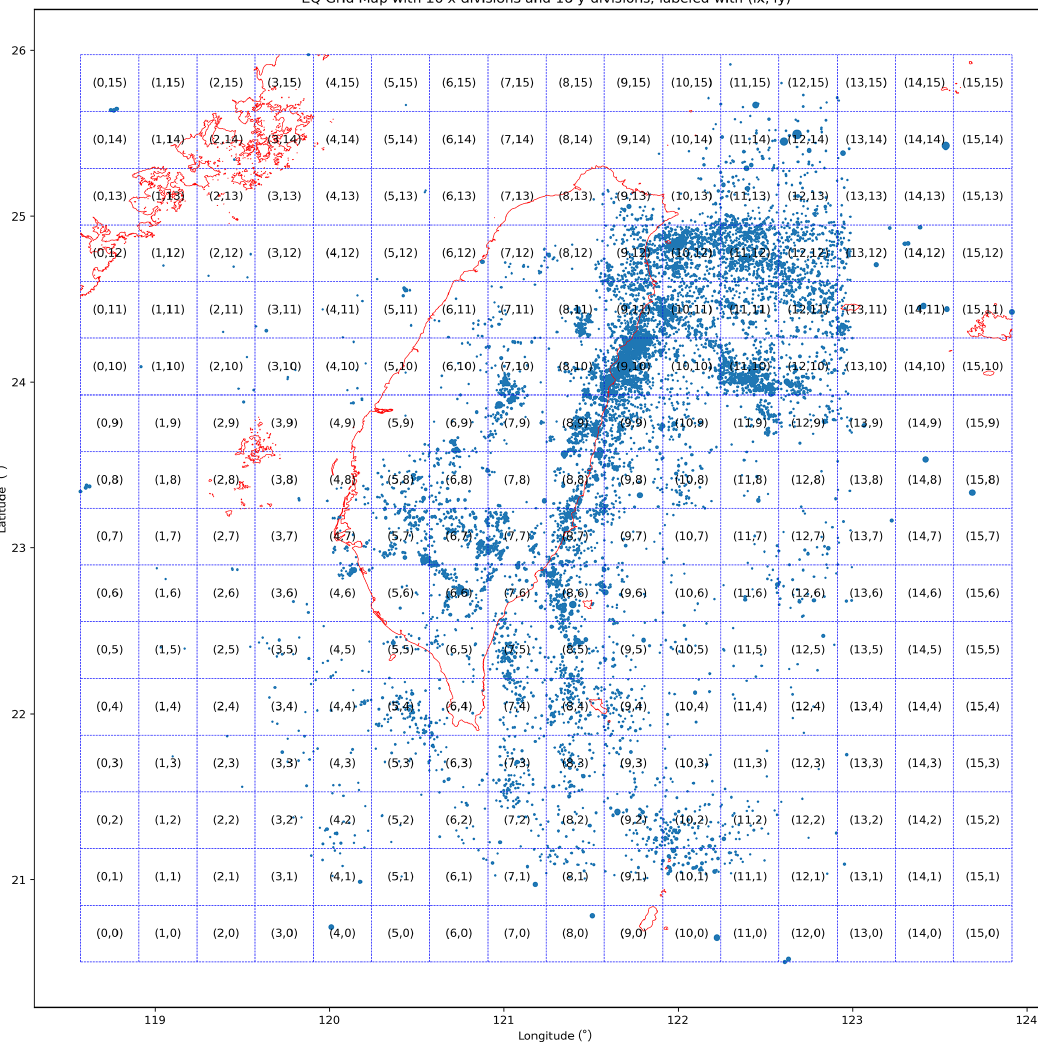
Figure 6. A sample EQ grid map with 16 by 16 divisions, in which each cell measures 0 . 3330 ◦ (longitude) by 0 . 3418 ◦ (latitude). All EQs of M L ≥ 3 are labeled with blue circles, with the radius of each circle being proportional to the natural exponential of the EQ’s